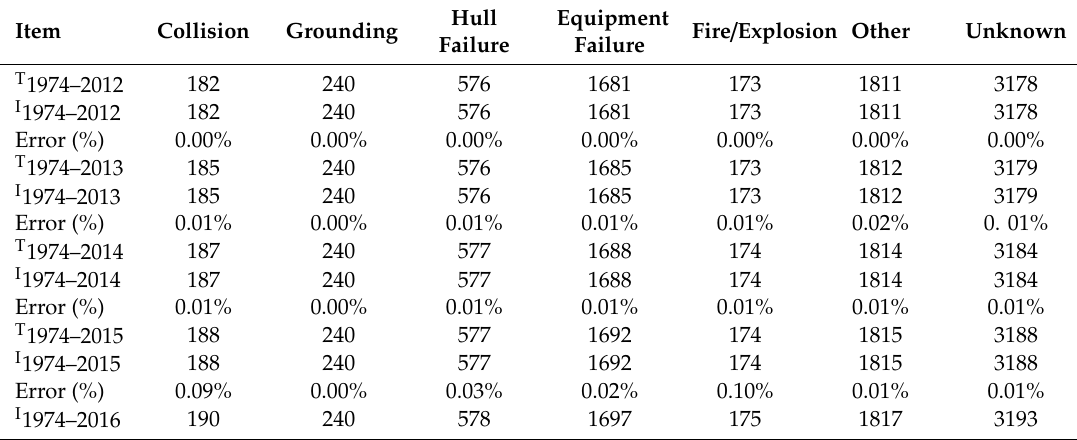
Table 5. Analysis of results of oil spills of less than 7 tons from 1974 to 2016.